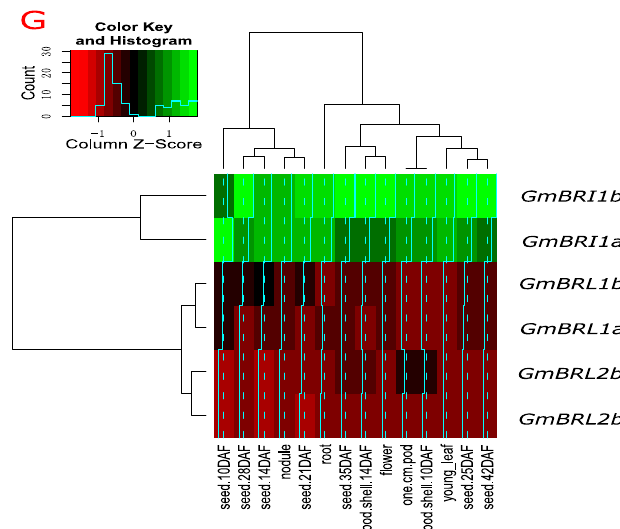
Figure 1. Expression of soybean BR receptors: GmBRI1b ( A ); GmBRI1a ( B ); GmBRL1a ( C ); GmBRIL1b ( D ); GmBRL2a ( E ); and GmBRL2b ( F ) in apical buds (b), cotyledons (c), epicotyls (e), hypocotyls (h), leaves (l), lateral roots (lr), and primary roots (pr). GmEF1a was used to normalize the qRT-PCR data. Results in ( A – F ) were means ± SD from three independent experiments, each of which were genes were downloaded from SoyBase [47] ( G ).